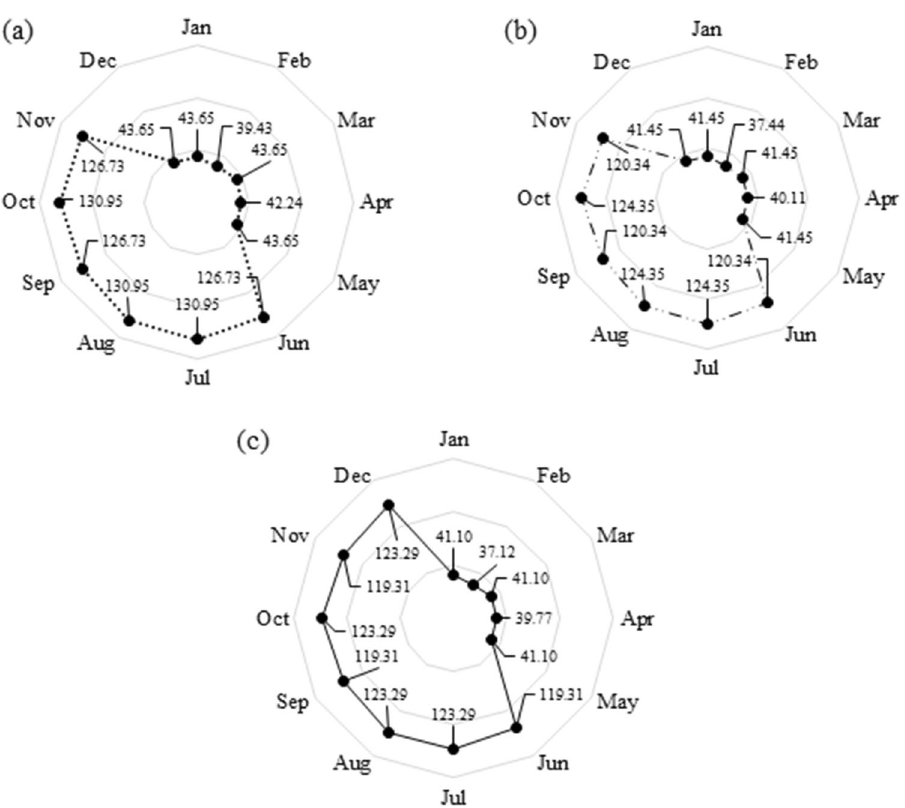
Figure 7. Estimated environmental demands under climate change conditions (10 6 × m 3 ): ( a ) RCP 2.6, ( b ) RCP 4.5, and ( c ) RCP